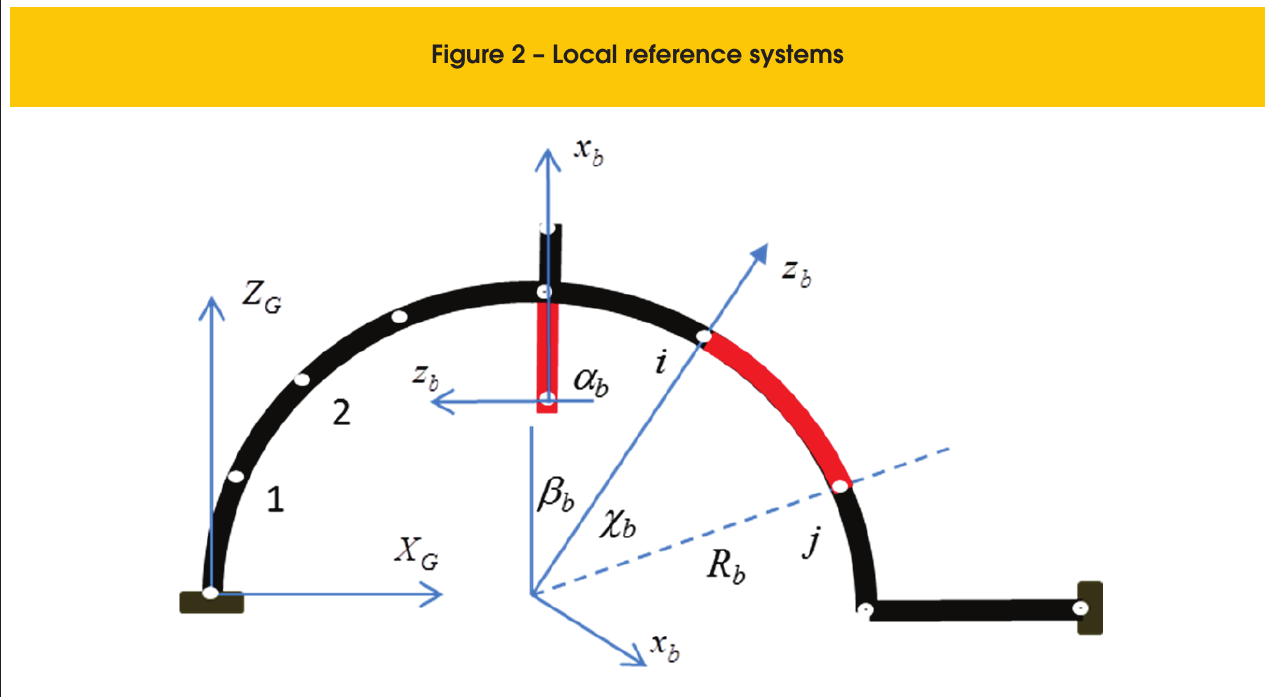
Figure 2 – Local reference